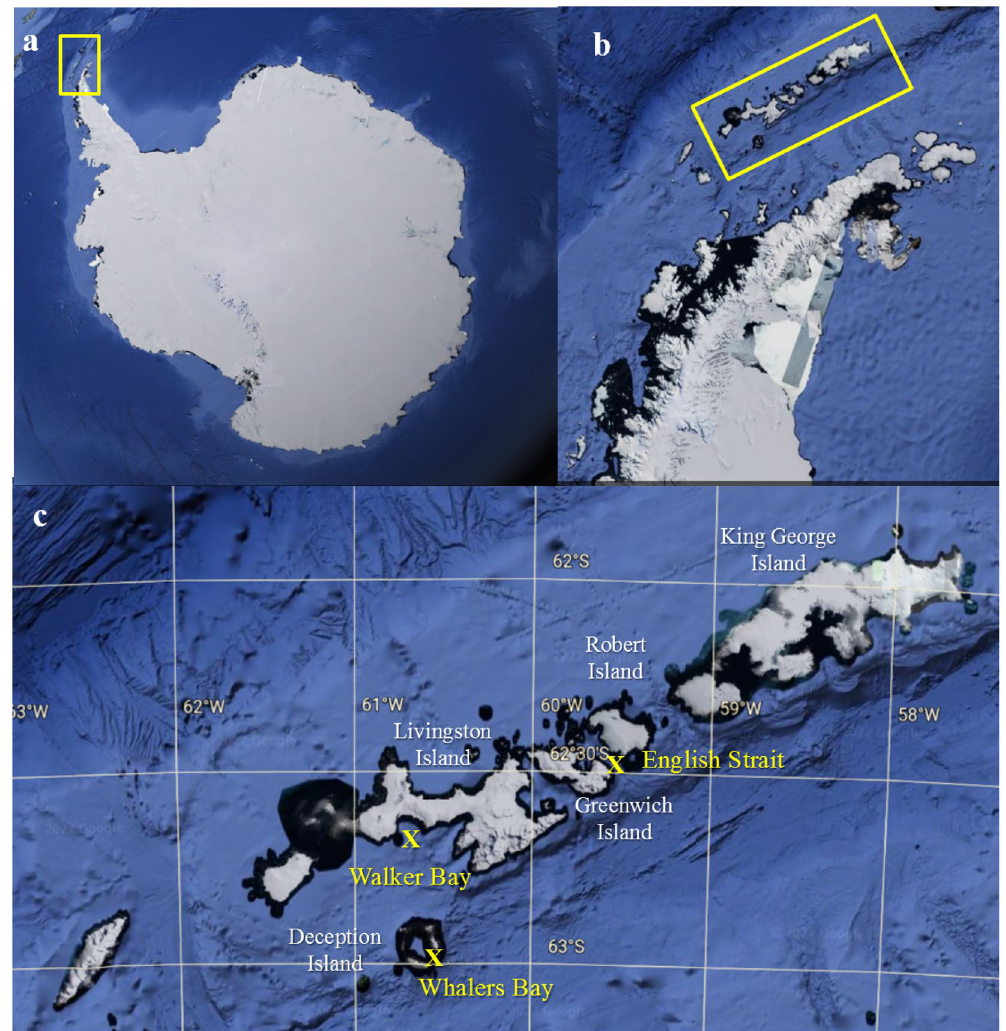
Figure 1. Satellite images of the study region from which samples were obtained, from Google Earth (https:// www. google. com. br/ maps/) Version 9.174.0.2 based on data from SIO, NOAA and U.S. Navy. ( a ) Antarctica, with the Antarctic Peninsula indicated within the yellow rectangle, ( b ) South Shetland Islands indicated within yellow rectangle, ( c ) sampling locations at Walker Bay (Livingston Island), Whalers Bay (Deception Island) and English Strait. Satellite images a and b obtained from Google Earth Pro, 2019 (https:// earth. google.